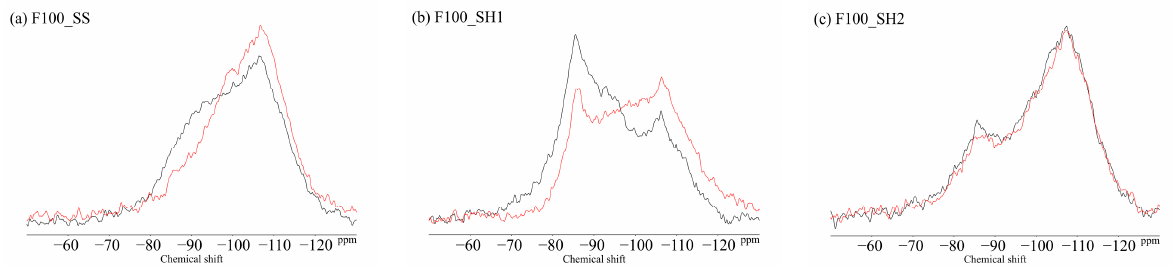
Figure 15. Changes in the colored areas of the mortar specimens after spraying with phenolphthalein and the correspond- ing changes in the pH values.